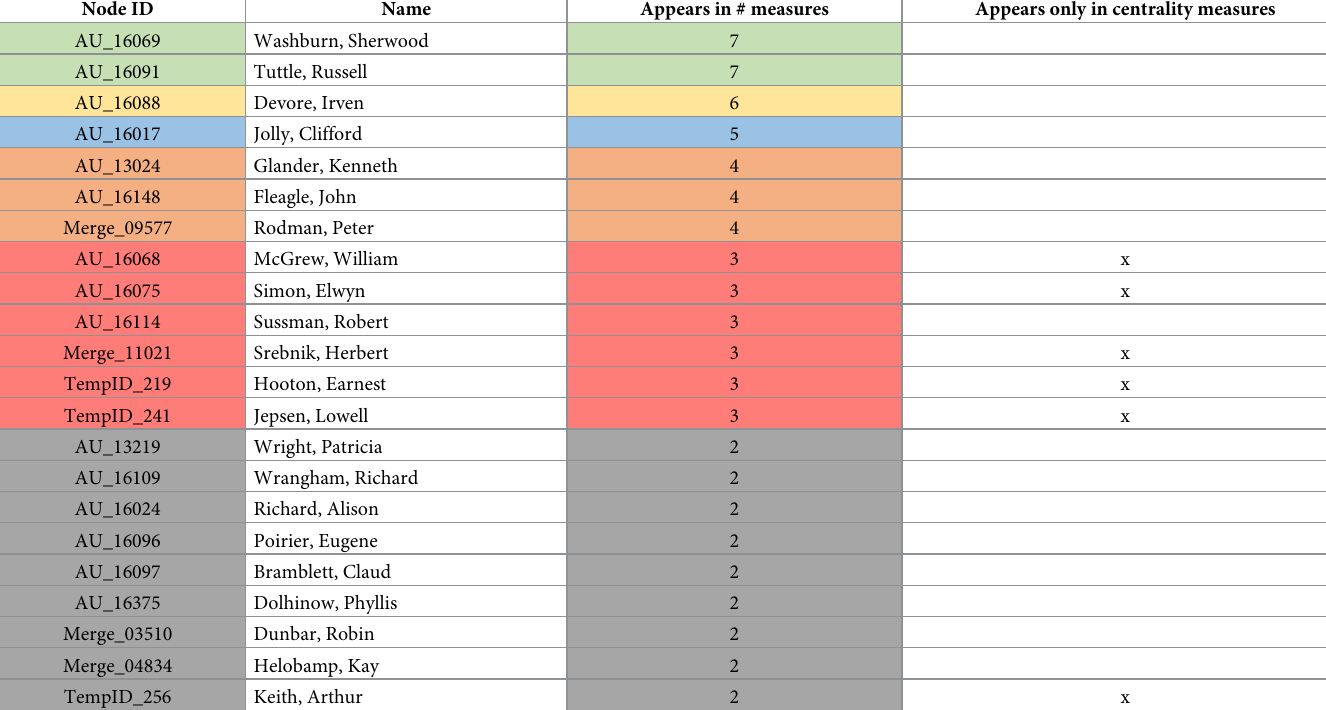
Table 5. Ranking of academics, with node ID’s associated with names, from Table 4 with the same colour coding. We flag were an academic has only appeared in cen- trality measures. Node